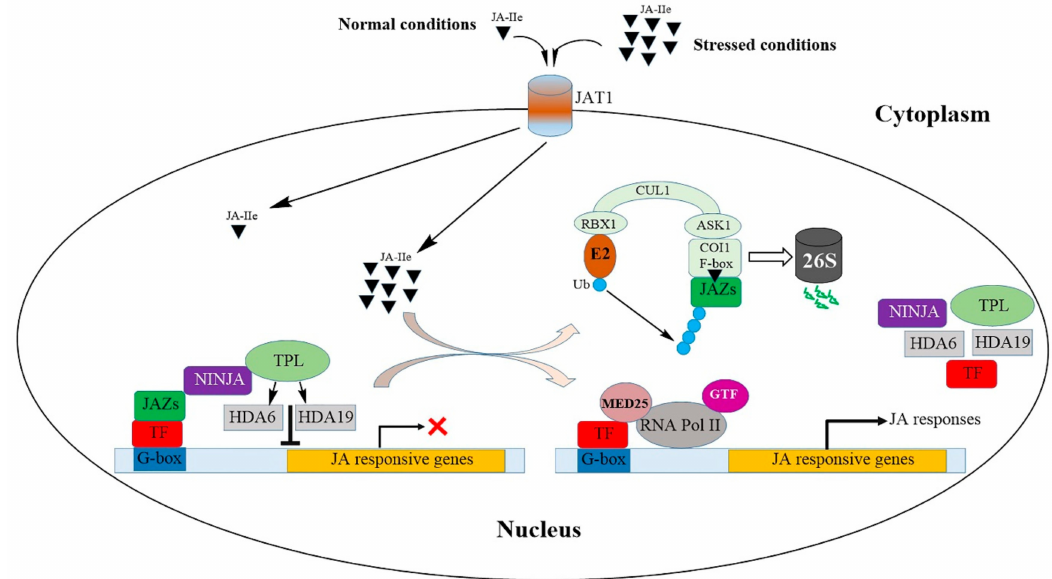
Figure 4. Jasmonic acid perception and signal transduction during abiotic stress. In the absence of abiotic stimuli or at a low level of JA-Ile, the transcription factors are repressed by JAZ proteins, thereby preventing their activation of the promoters of jasmonate-responsive genes. JAZ proteins recruit TPL and adaptor protein NINJA to form an active transcriptional repression complex that inhibits JA responses by changing the open complex to a closed one through the further recruitment of HDA6 and HDA19. Abiotic stresses elevate JA synthesis, which is readily epimerized to JA-Ile. The latter is then transported to the nucleus by the JAT1 transporter. JA-Ile facilitates the interaction of JAZ with the F-box protein COI1 within the SCF complex, leading to the proteasomal degradation of JAZ. The derepressed TF binds to the G-box element, whereupon MED25, RNA Pol II, and GTF are recruited, resulting in the expression of jasmonate-responsive genes. JA, jasmonic acid; JA-Ile, jasmonyl isoleucine; JAT1, jasmonic acid transfer protein 1; TF, transcription factor; JAZ, jasmonate ZIM domain; NINJA, novel interactor of JAZ; TPL, topless; HDA6, HDA19, histone deacetylase 6, 19; Ub, ubiquitin; E2, ubiquitin-conjugating enzymes; RBX1, ring box 1; CUL1, cullin 1; ASK1, Arabidopsis SKP1 homolog 1; COI1, coronatine insensitive 1; MED25, mediator 25; RNA Pol II, RNA polymerase II; GTF, general transcription